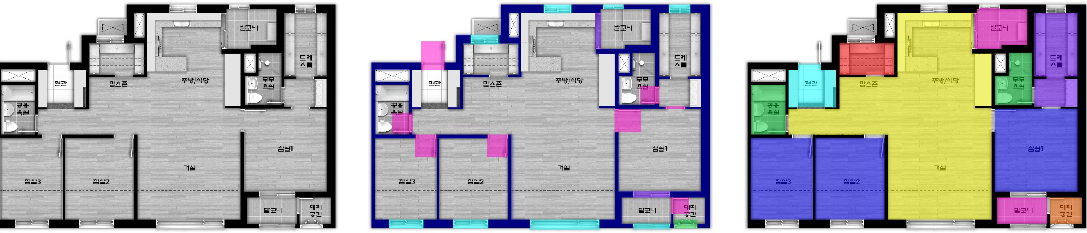
Figure 6. Example of data labeling process: pre-processed image ( left ), labeling of drawing elements ( center ), labeling of space usage ( right ) (The transparency was set to 55% to ensure visibility.).